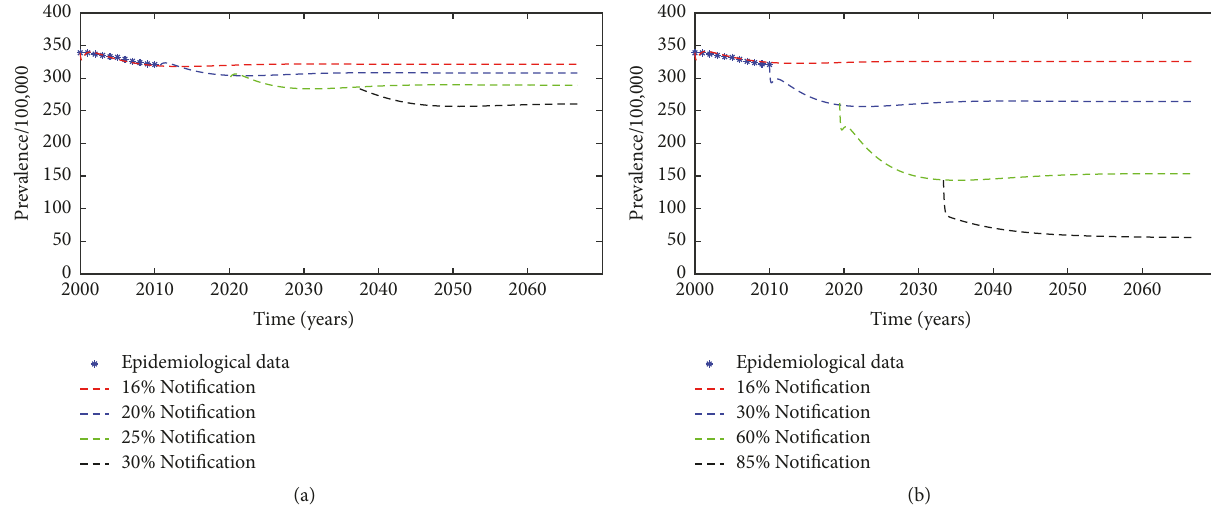
Figure 6: Hypothesis 1: effective strategies in a gradual increase in tuberculosis notification in the case of poor tuberculosis surveillance. (a) Result of the prediction made by the model when the notification of new tuberculosis cases is gradually increased. The red curve shows the poor notification rate situation, which represents the present situation of tuberculosis in Nigeria (the blue stars). The rest of the curves represent a change in case detection and increasing in the notification of new cases by some percentagesover a period of time. (b) Result of the prediction made when the notification of new tuberculosis cases is suddenly